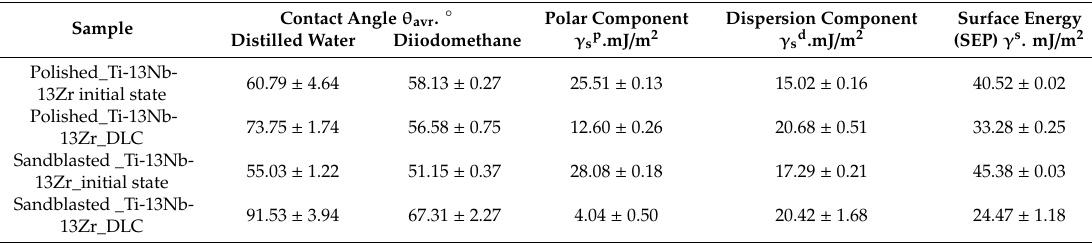
Table 2. Results of the wettability and surface energy.